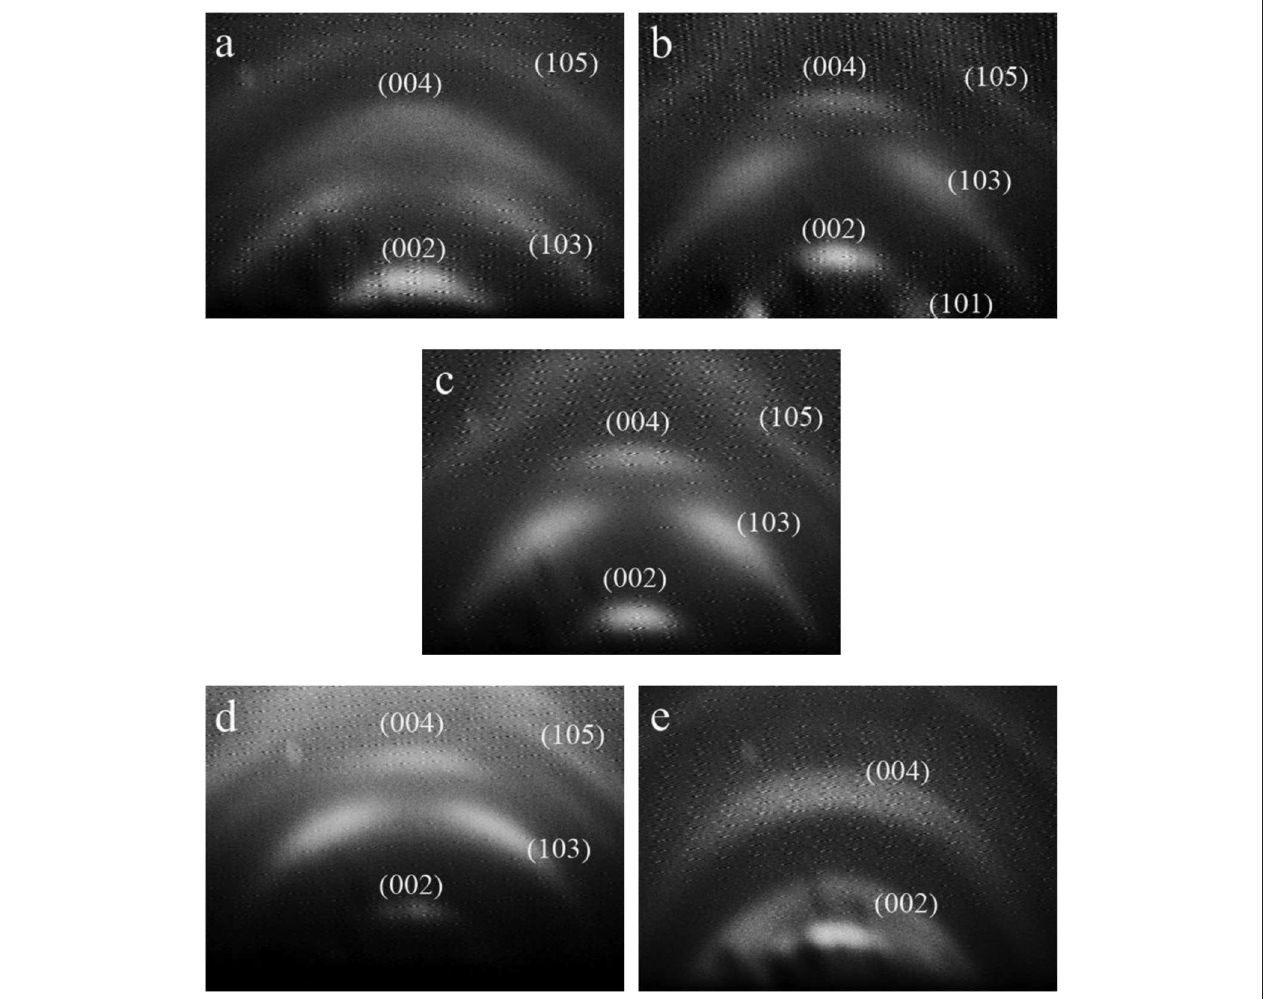
FIGURE 1 | The RHEED patterns of InN (0002) plane films at various N 2 flux for (a) 60 sccm, (b) 70 sccm, (c) 80 sccm, (d) 90 sccm, and (e) 100 sccm, respectively.